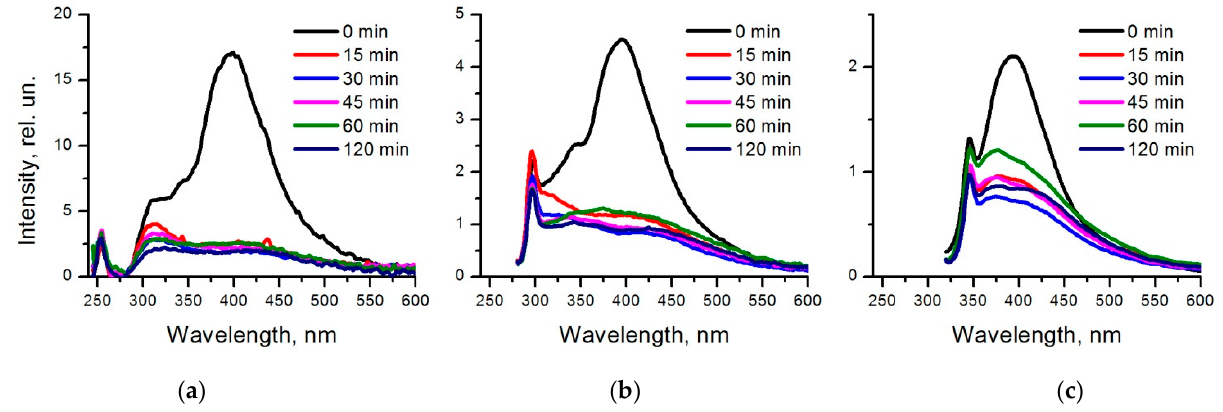
Figure 3. Fluorescence emission spectra of initial lignosulfonate (0 min) and LH-samples at different processing periods at excitation wavelengths 235 ( a ), 270 ( b ), and 310 nm ( c ). All spectra were corrected for the “inner-filter” effect.